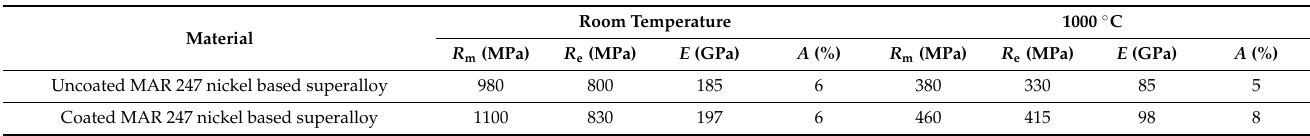
Table 3. Selected mechanical properties for coated and uncoated MAR 247 nickel based superalloy after uniaxial tensile test performed at room temperature and 1000 ◦ C.